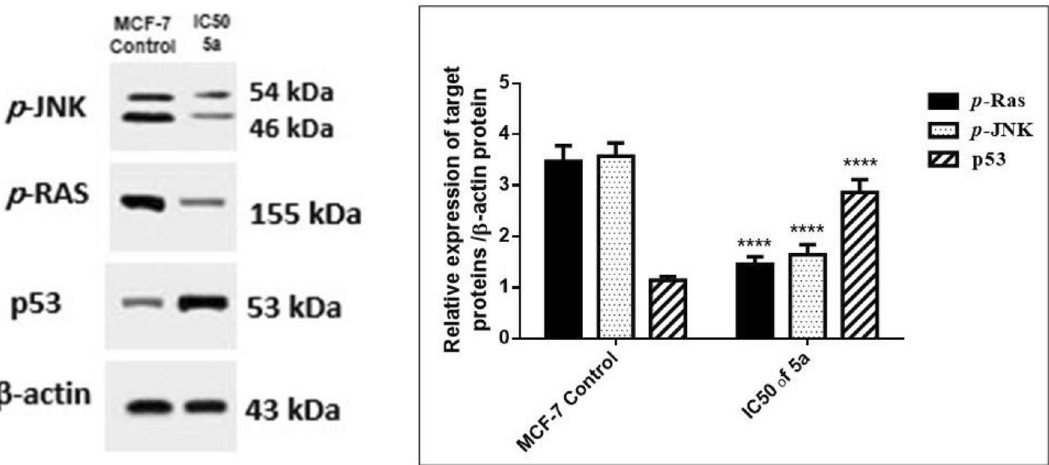
Figure 9. Relative expression of p -JNK, p -RAS and p53 cropped gel proteins/β-actin protein in human breast cancer cells MCF-7 after 48 h treatment. Results are expressed as mean ± SE, (n = 3). p < 0.05 is considered significant, where * : significantly different from the control group. The original blots/gels are presented in supplementary Figs. (S-27 for p -JNK, S-28 for p -RAS, S-29 for p53, and S-30 for β-actin).